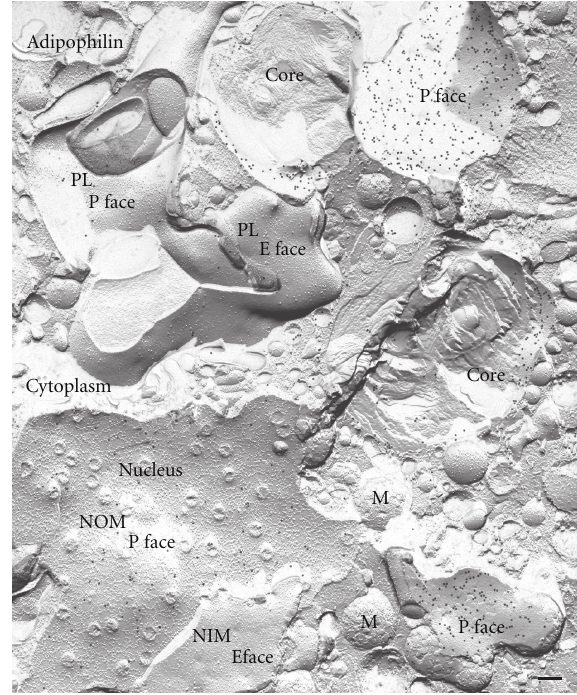
Figure 6: Freeze-fractured nuclear membrane in a lipid-laden macrophage after immunogoldlabeling for adipophilin. Apart from positive labeling of lipid droplets, the P face of the outer nuclear membrane (NOM) is prominently labeled. The E face of the outer nuclear membrane and both fracture faces of the inner nuclear membrane (NIM) are typically devoid of label. Bar: 0.2 μ